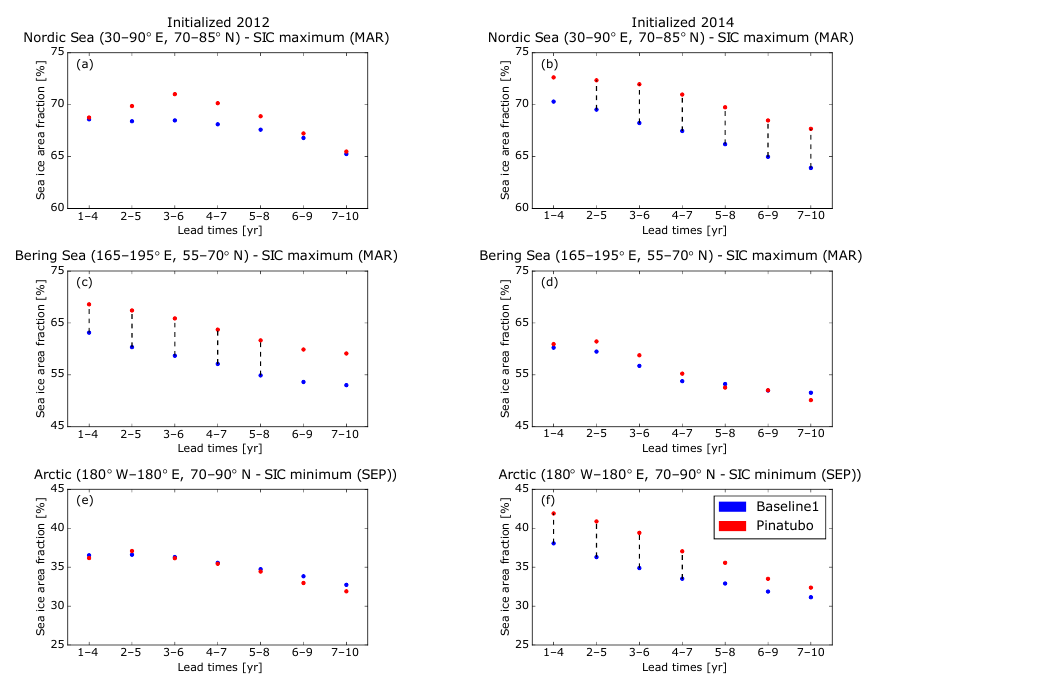
Figure 6. Same as Fig. 2, but for sea ice area fraction (SIC) maximum and minimum and different regions. (a, b) Nordic Sea (30–90 ◦ E, 70–85 ◦ N), (c, d) Bering Sea (165–195 ◦ E, 55–70 ◦ N), and (e, f) the Arctic (180 ◦ W–180 ◦ E, 70–90 ◦ N). Dashed lines indicate significant differences between the values at the 5%